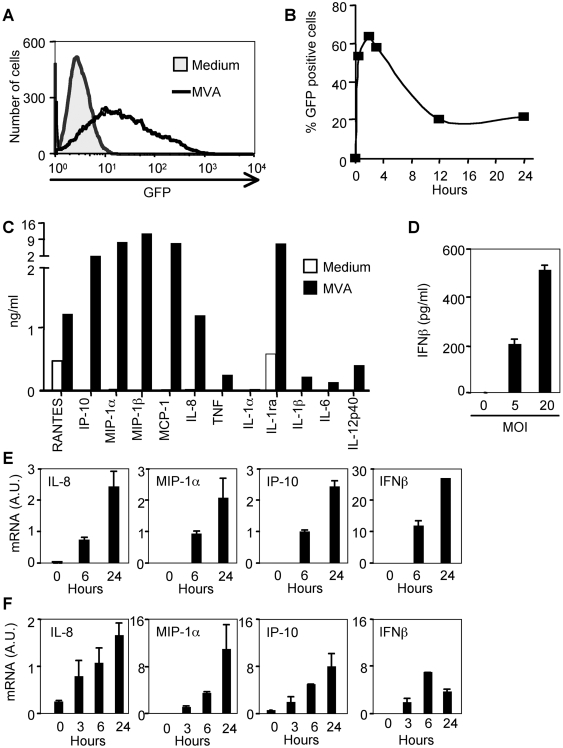
MVA induces the production of cytokines, chemokines and IFNβ by human macrophages.Human THP-1 cells (A–E) and primary human macrophages (F) were infected with GFP-positive (A, B) or wild-type (C–F) MVA (MOI 5). Expression of viral-derived GFP protein by THP-1 cells analyzed by flow cytometry (A, B). Cytokines, chemokines and IFNβ production by THP-1 cells stimulated for 24 h with MVA as assessed by the Luminex technology (C) or by ELISA (D). IL-8 (CXCL8), MIP-1α (CCL3), RANTES (CCL5), IP-10 (CXCL10) and IFNβ mRNA levels were analyzed by RT-PCR and results expressed as the ratio of chemokines or IFNβ to HPRT mRNA levels. AU: arbitrary units (E, F). Data are means±SD of duplicate (C) or triplicate (D to F) samples from one experiment and are representative of one (C) to three (D to F) independent experiments. p<0.05 for all conditions (D to F).